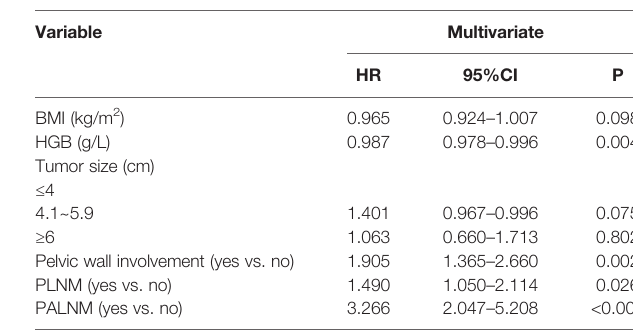
TABLE 4 | Multivariate analysis for progression-free